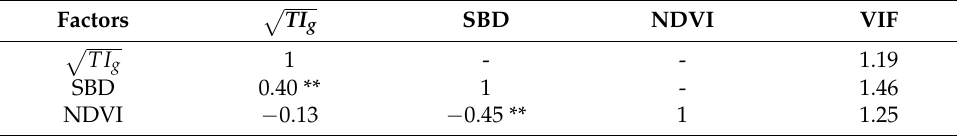
Table 1. Correlation between the various influencing factors of